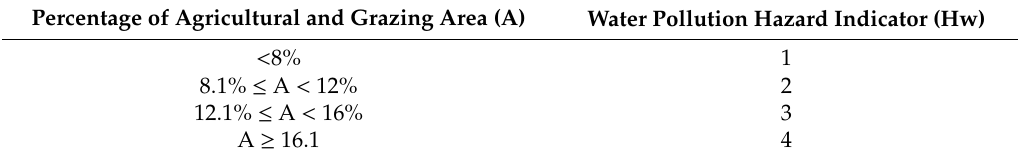
Table 6. Values of the water pollution hazard (Hw) for di ff erent percentage of agricultural and grazing areas (A), Hw varies from 1 (lower) to 4 (higher). Percentage of Agricultural and Grazing Area (A) Water Pollution Hazard Indicator (Hw)